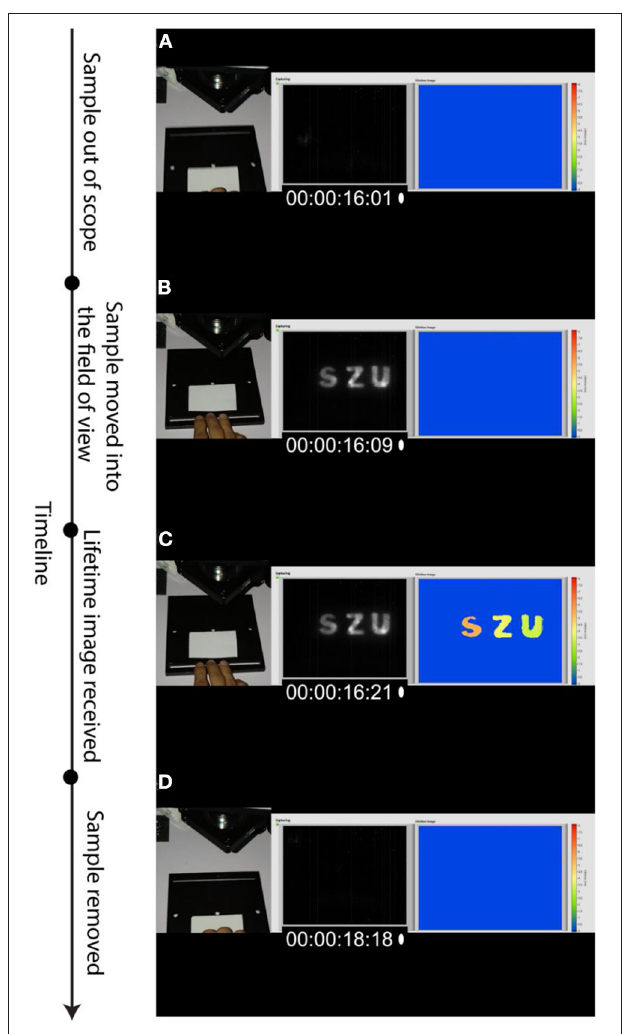
FIGURE 5 | Timeline and major stages of RLD-assisted real-time decoding of SWIR PL pattern illustrated by the photographic images, selected video frames, and corresponding screens of the RLD-based software decoding lifetimes. Timecode (00:00:xx:yy) in every presented video frame shows seconds of the video (xx) and number of the frame within current second (yy). (A) The paper with invisible pattern is to be moved into the imaged area (time: 16s, frame 1). (B) SWIR PL intensity image appearing when the pattern is moved into the imaging area (time: 16s, frame 9). (C) Lifetime image generated after receiving two sequential time-gated images with different delays followed by RLD-based processing (time: 16s, frame 21). (D) The paper with invisible pattern is moved out of the imaged area (time: 18s, frame